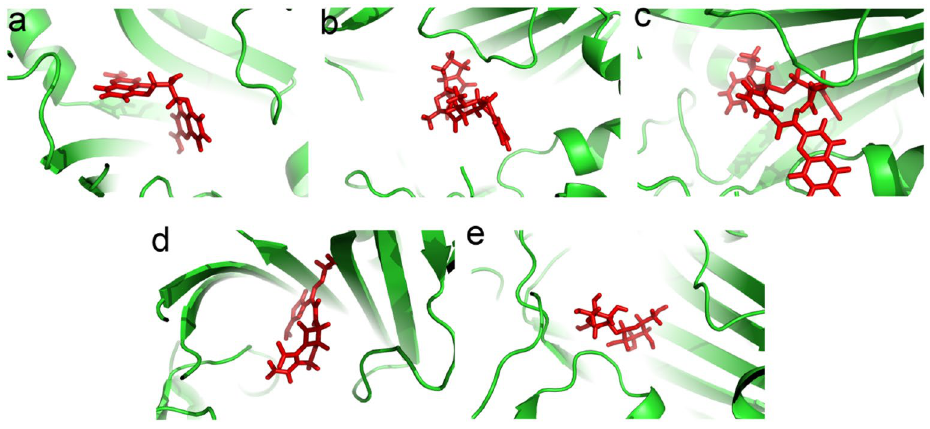
Figure 2. The best drugs with high affinity bind in the groove of the TgPRS protein. ( a ) Cromolyn, ( b ) Ergotamine, ( c ) Montelukast, ( d ) Cefexim, ( e ) Lactulose. The figures are created by using PyMOL Version